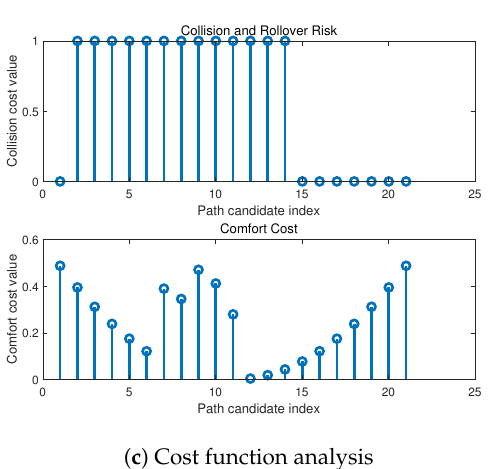
Figure 11. Multiple obstacle path selection: ( a ) an XY view on obstacles; the light color indicates z > 0; the dark color indicates z < 0; ( b ) path selection result in a three-obstacle model: the selected path avoids a rollover risk obstacle and a collision risk obstacle and passes over a non-rollover risk obstacle; ( c ) path candidate collision and rollover cost analysis and comfortability cost analysis